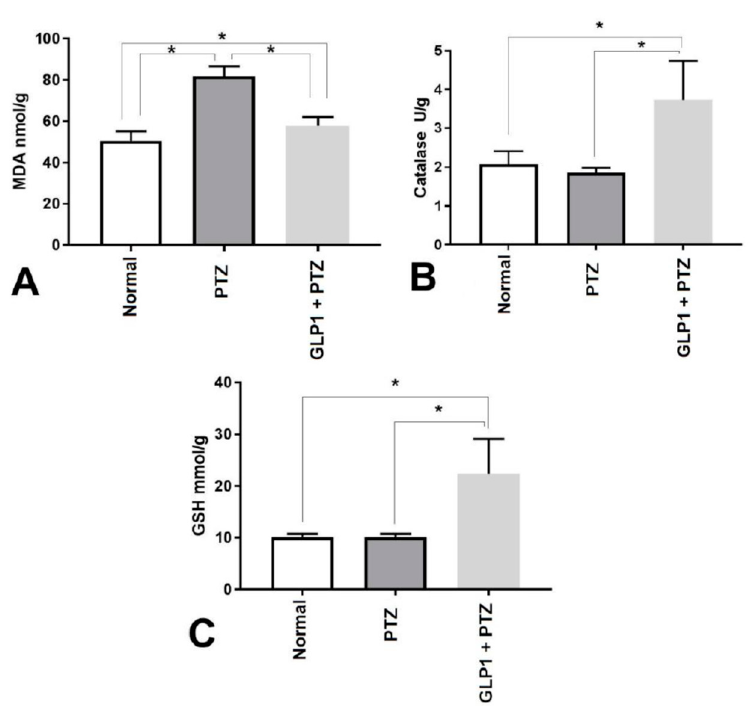
Figure 2. Effects of GLP1 on lipid peroxidation product (MDA concentration (nmol/g brain tissue) ( A ), and catalase enzyme activity (U/g brain tissues) ( B ) and reduced glutathione (GSH) (mmol/g brain tissues) ( C ). One ‐ way ANOVA with Tukey posthoc test. *, Statistical significant difference between two groups.